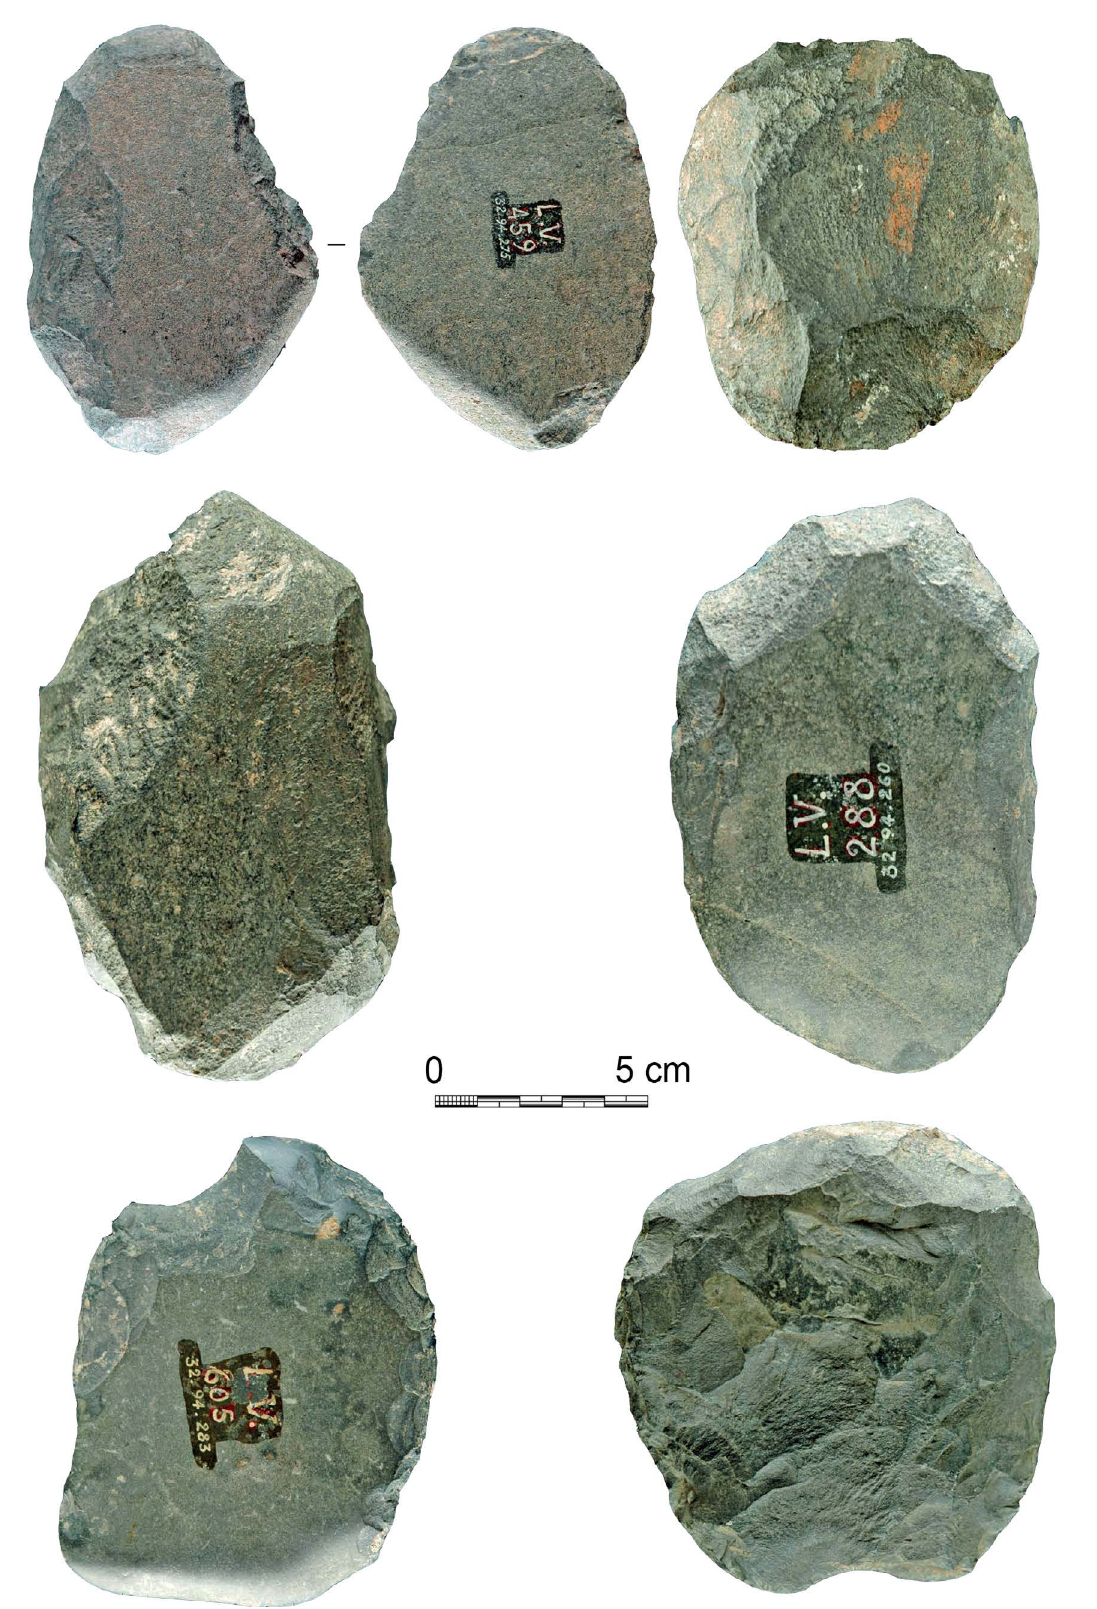
Figure 2. Outils typiques hoabinhiens, Nord Vietnam (Coll. Colani 1932, Musée de l’Homme, Paris) (H. Forestier). Figure 2. Typical Hoabinhian pebble tools from North Vietnam (Colani Coll. 1932, Musée de l’Homme, Paris) (H.